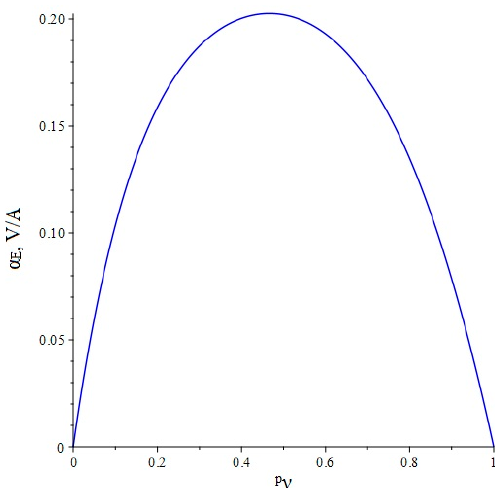
Figure 16. Theoretical dependence of the ME voltage coefficient on the volume fraction of the piezoelectric material for the asymmetric ME structure Metglas/GaAs for the quasi-static mode of the torsional and longitudinal-shear modes.